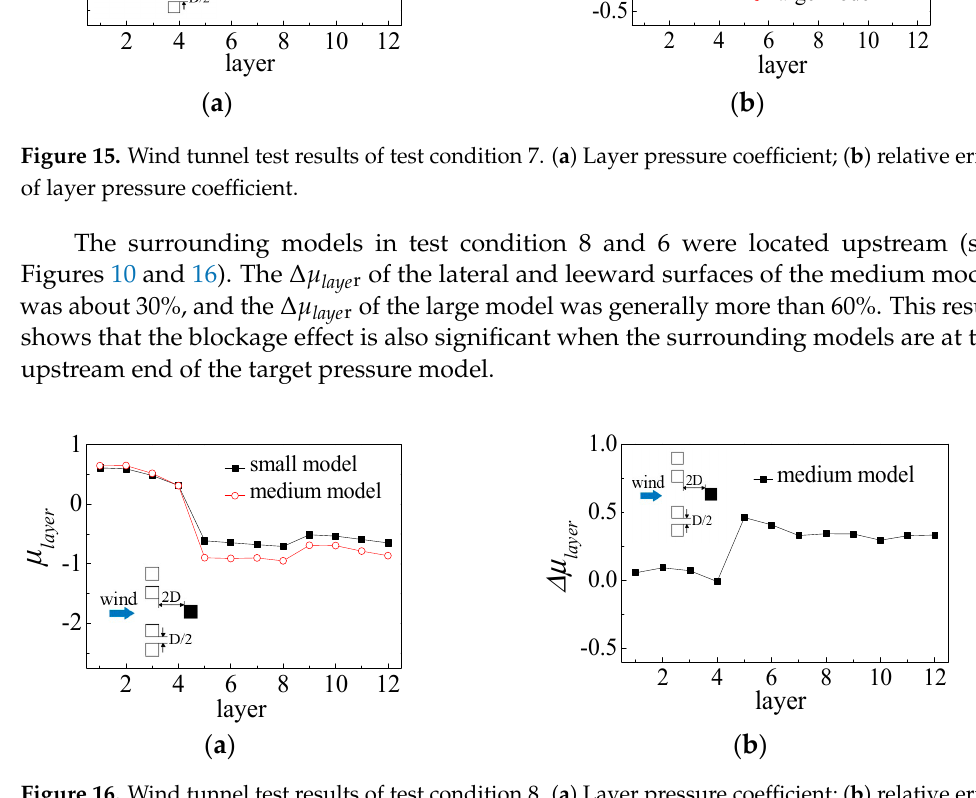
error of layer pressure coefficient. of layer pressure